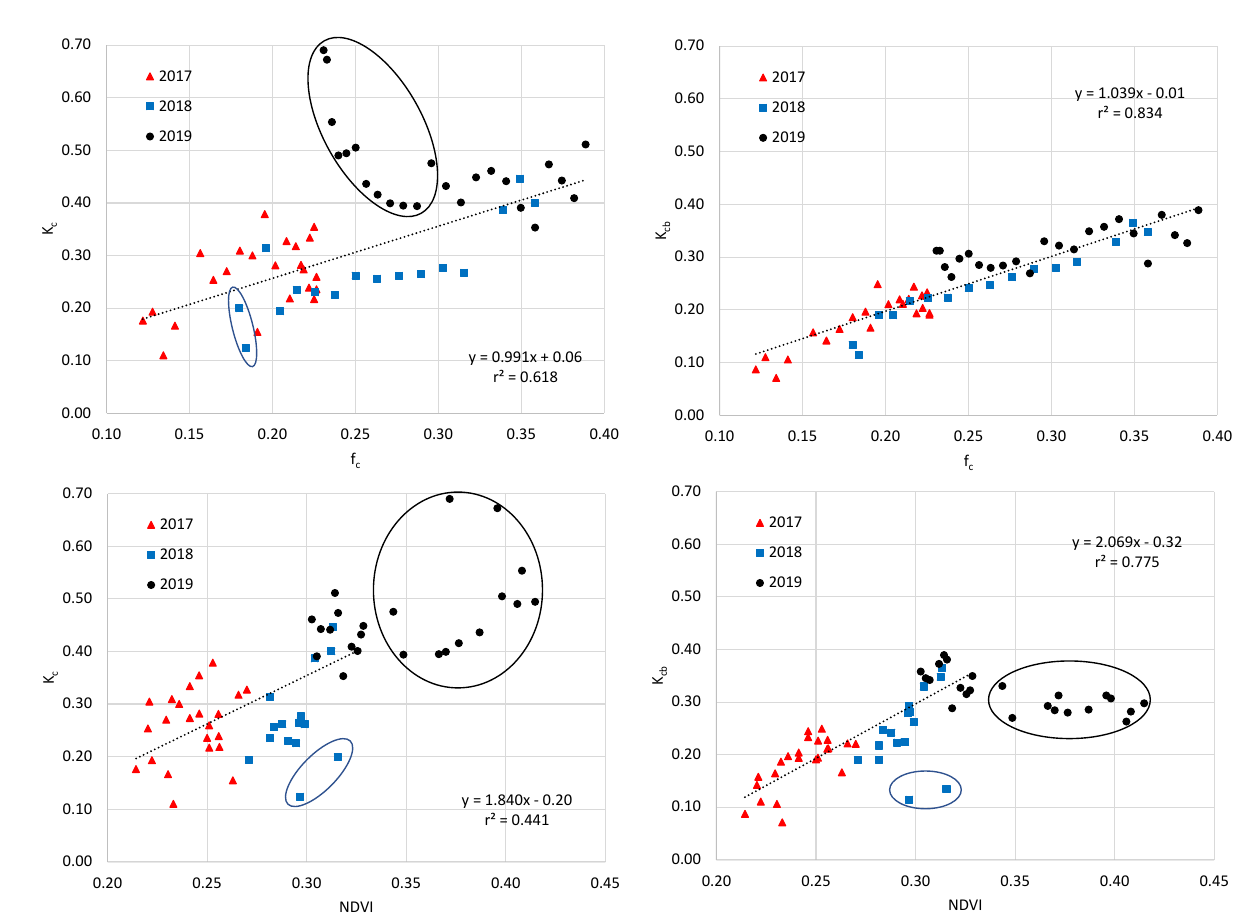
Figure 12. Crop coefficients versus f c ( up ) and NDVI ( down ) values. Left plots show the single crop coefficient, K c , whereas right plots show the basal crop coefficient, K cb . A dashed line represents the linear regression, and statistics for the linear fittings are inserted. Circled data correspond to spring dates affected by the non-removed ground green weeds. These points were excluded from the linear regressions shown.